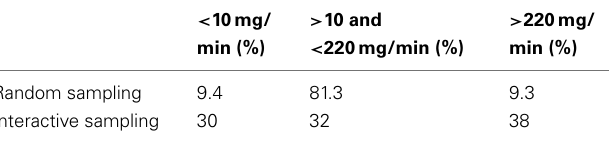
Table 1 | Percentage of episodes revealed by an random or interactive sampling separated into three categories: above the selected activity threshold, between the selected activity and inactivity threshold, and below the selected inactivity threshold (please note, that the upper line “random sampling” corresponds to the white bars in Figure 4 and the lower line ”interactive sampling” to the gray